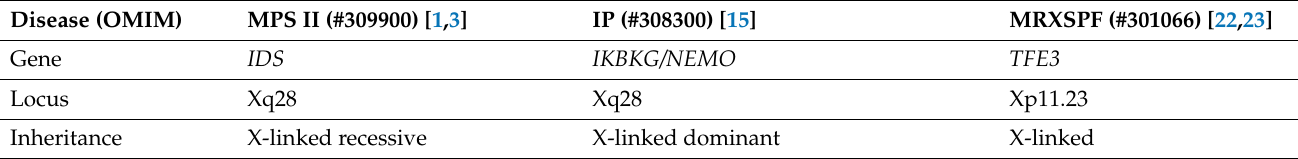
Table 1. Comparative table of the characteristics of three disorders: Mucopolysaccharidosis type II (MPS II), Incontinentia pigmenti (IP), X-linked syndromic intellectual developmental disorder with pigmentary mosaicism and coarse facies